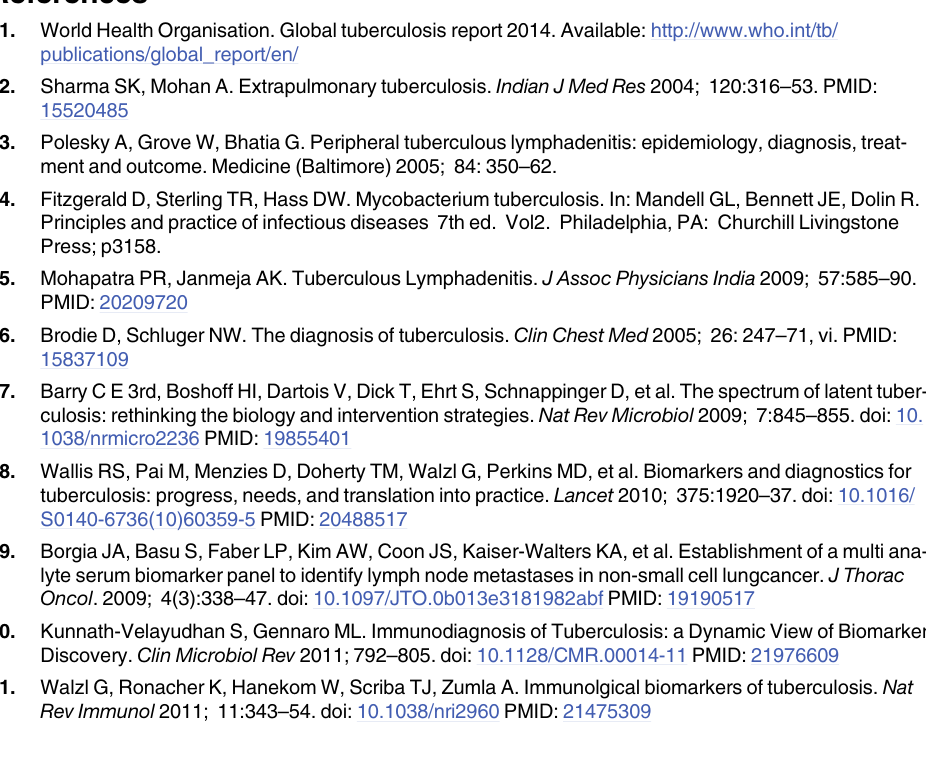
S9 Table. Decision tree model original and predicated class. S10 Table. Concordance of the prediction between the decision tree and the multiple logis- tic regression